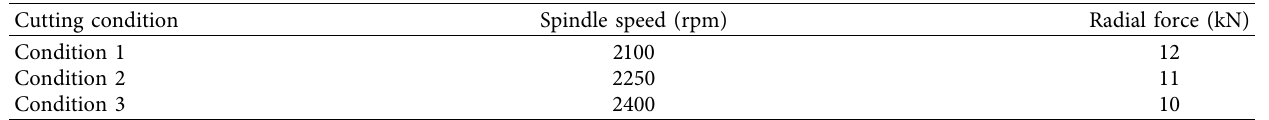
Figure 10: A testbed of rolling element bearings. Table 1: Bearings’ operation